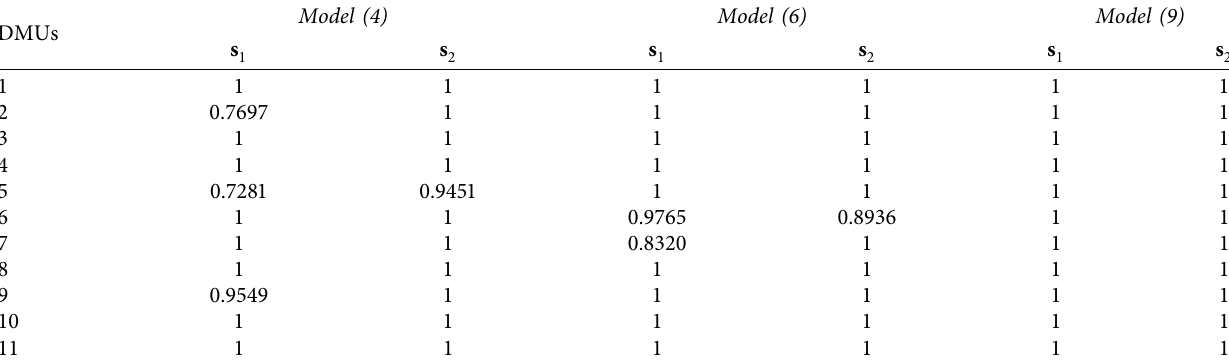
Table 5: Ideal efficiency scores under scenarios for models (4), (6) and (9).